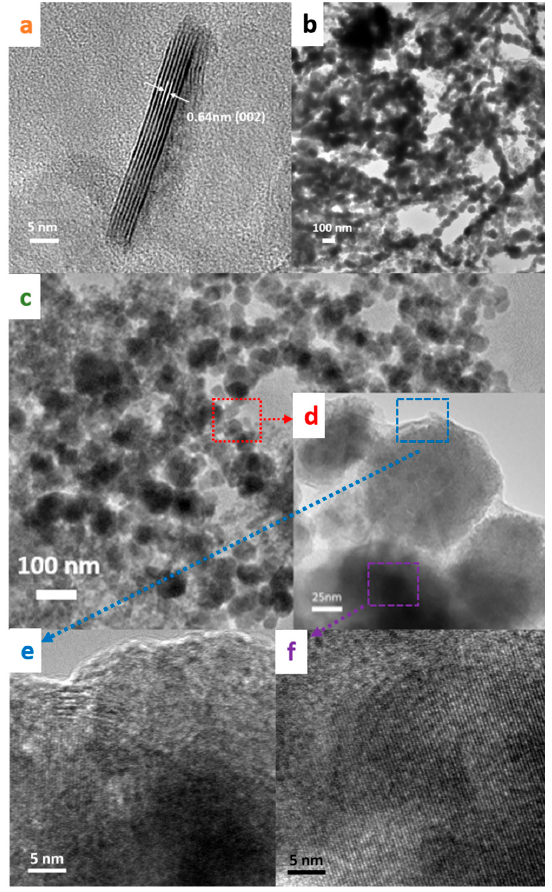
Figure 4. TEM images of ( a ) MNs, ( b ) bare nZVI, ( c ) MFNNs, ( d ) the red rectangular region in Figure 4c at a higher magnification, ( e ) the blue rectangular region in Figure 4d at a higher magnification, ( f ) the purple rectangular region in Figure 4d at a higher magnification.